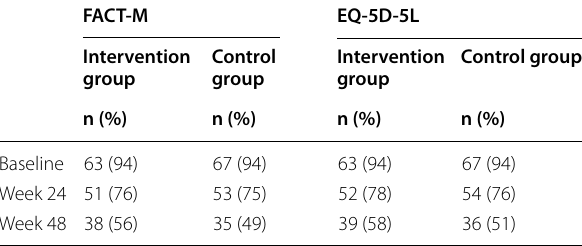
Table 1 Participant baseline characteristics Table 2 Completion rates over time for HRQoL